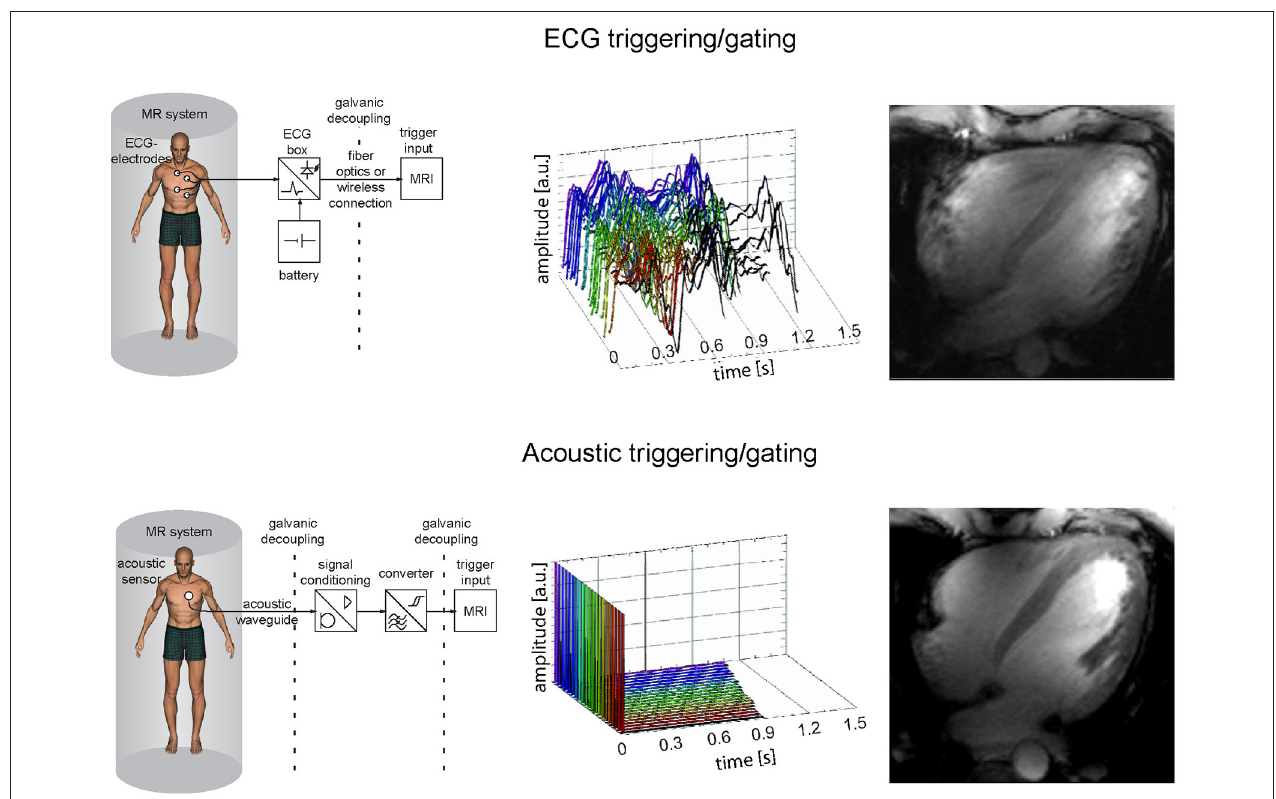
FIGURE 4 | Comparison of ECG and acoustic triggering or gating showing system schemes (left), signal traces acquired in the isocenter of a 7.0 T magnet for 18 cardiac cycles (middle) and corresponding four chamber views acquired at 7.0 T with the respective approaches (right). The ECG gated image shows severe artifacts due to incorrect cardiac synchronization, while the acoustically triggered image reveals decent image quality with good blood myocardium contrast and clear delineation of subtle